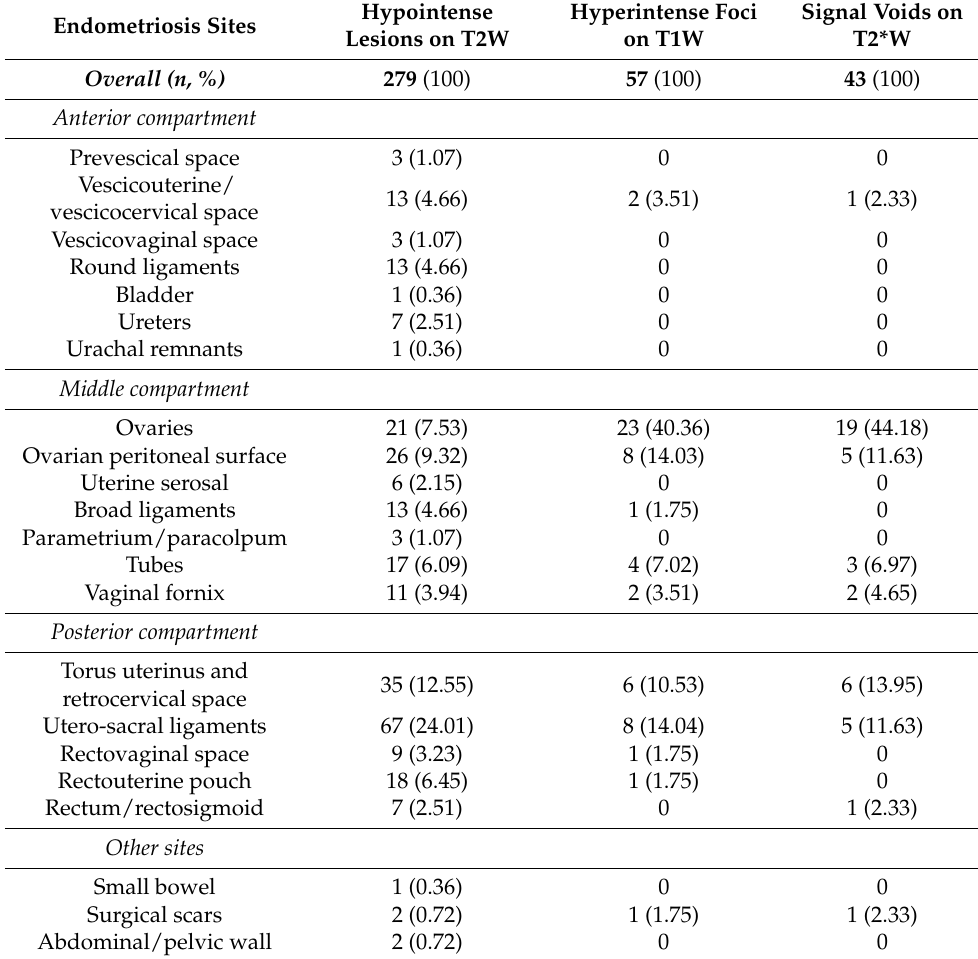
Table 3. Localizations and MRI signal characteristics of endometriotic lesions detected by the most experienced observer ( Reader 1